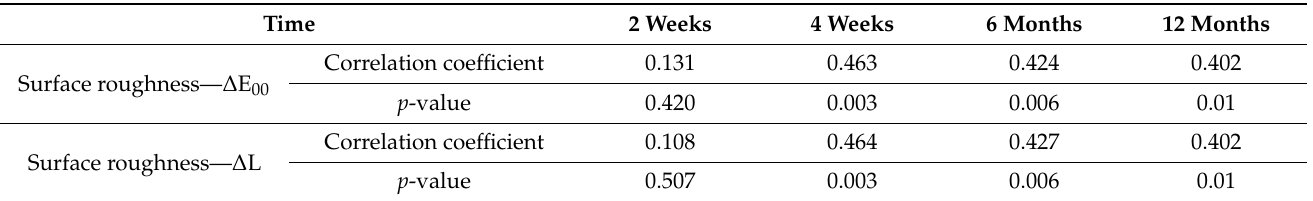
Table 6. Spearman’s correlation test was used to assess two pairs at each time point: surface roughness and ∆ E 00 , as well as surface roughness and ∆ L.